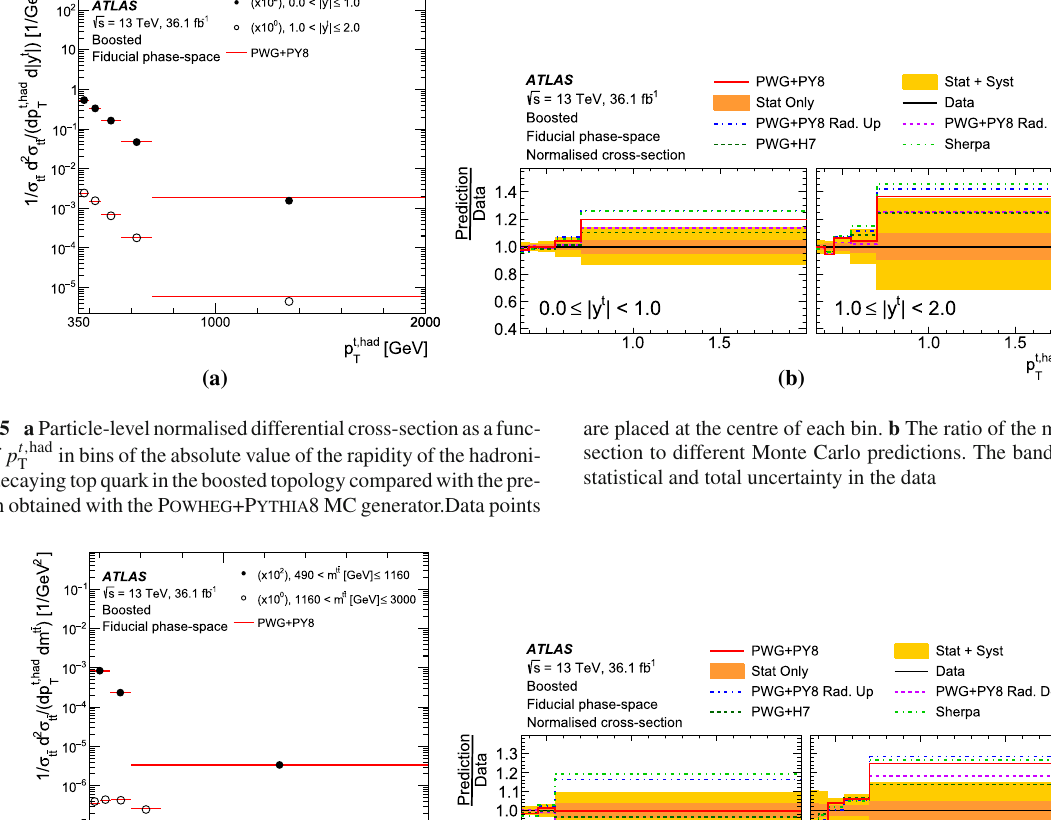
generator. Data points are placed at the centre of each bin. b The ratio of the measured cross-section to different Monte Carlo predictions. The bands represent the statistical and total uncertainty in the data